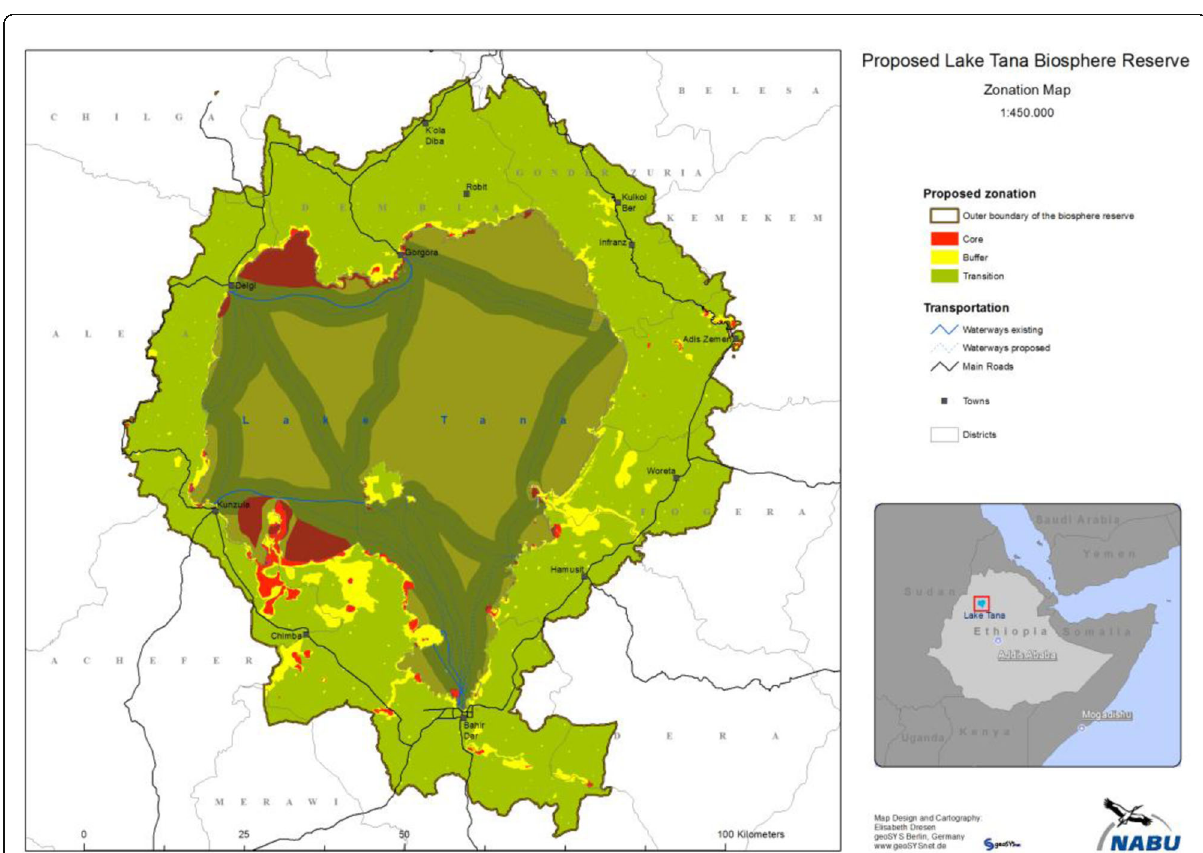
Fig. 11 The map of Lake Tana Biosphere Reserve (BR) area taken from NABU